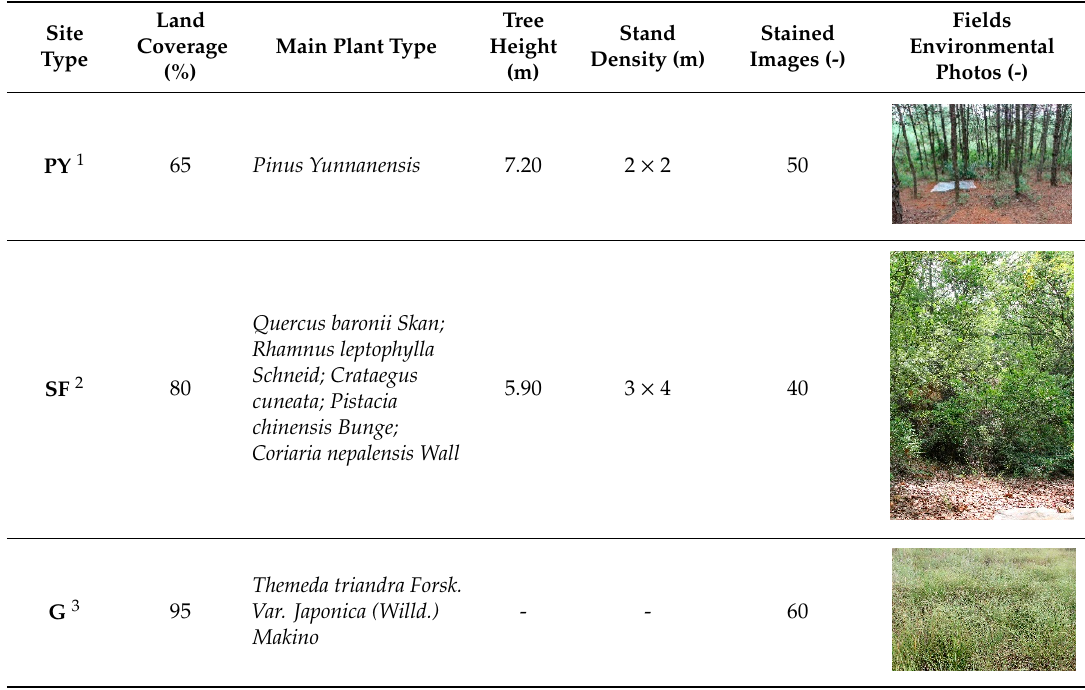
Table 1. Basic situation of the experimental sites.